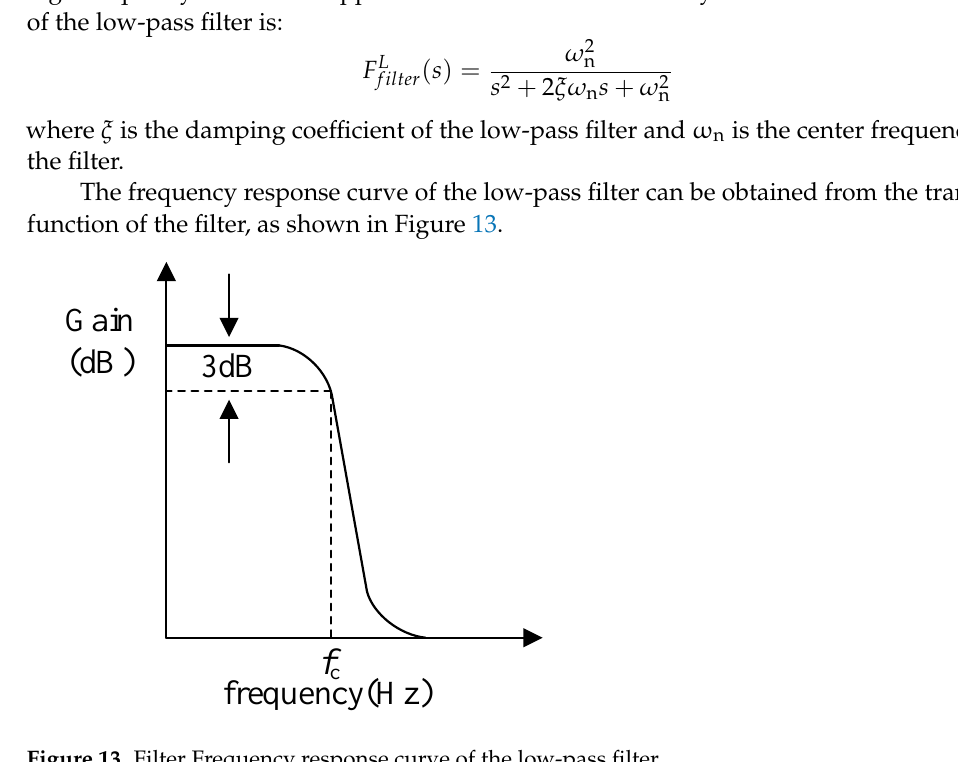
Figure 13. Filter Frequency response curve of the low-pass filter.